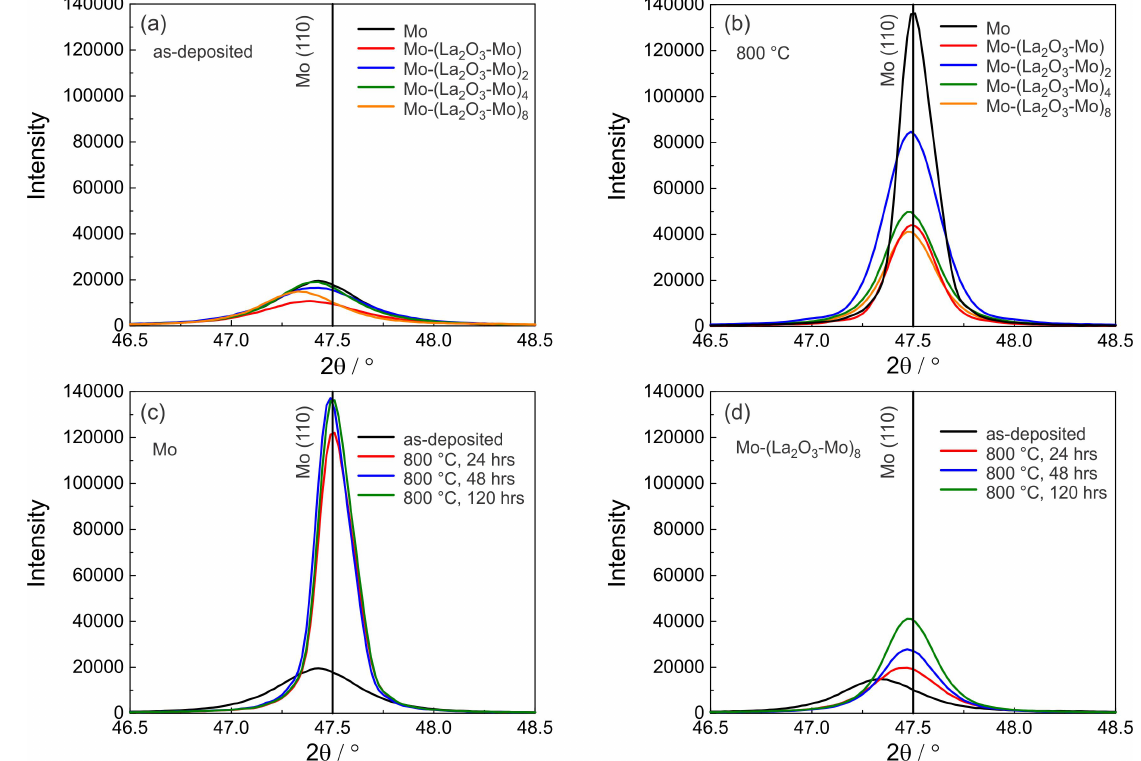
Figure 6. X-ray diffraction (XRD) pattern (range around the Mo (110) peak position) of the pure Mo and the Mo-(La 2 O 3 -Mo) n films (Bragg-Brentano geometry, Co-K α ), ( a ) in the as-deposited state and ( b ) after thermal treatment in high vacuum at 800 ◦ C for 120 h. ( c ) Pure Mo and ( d ) the Mo-(La 2 O 3 -Mo) 8 multilayer system, both in as-deposited state and annealed at 800 ◦ C for 24 h, 48 h and 120